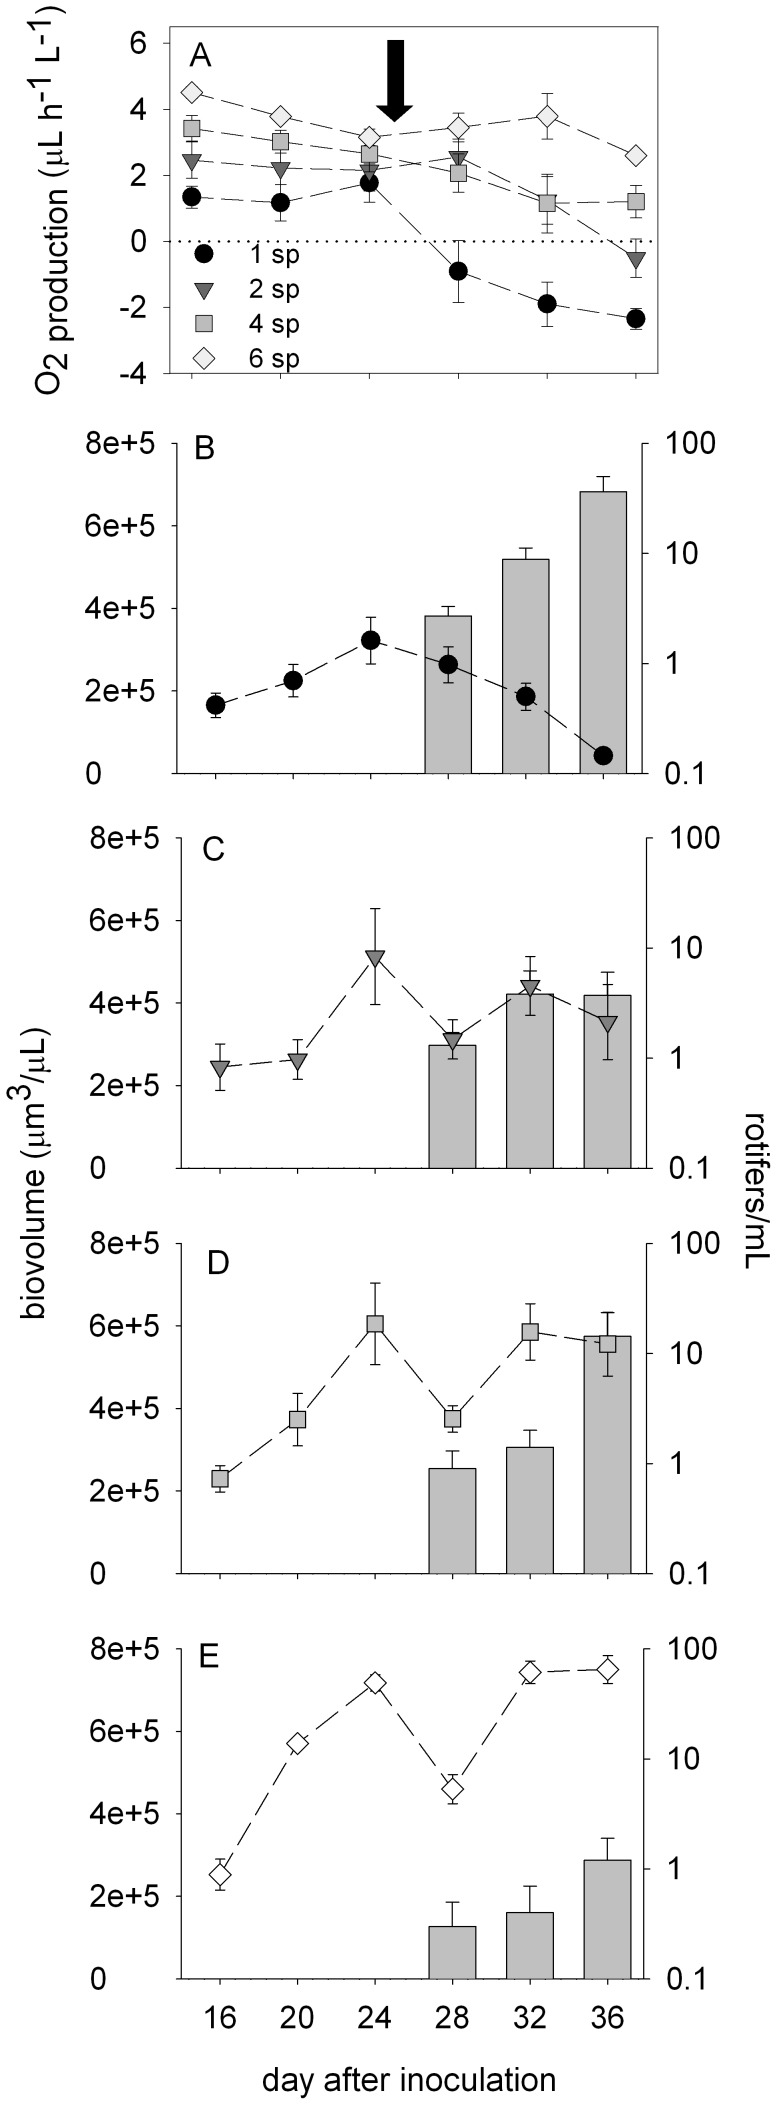
Oxygen production, phytoplankton biovolume and rotifer abundance through time in the different richness treatments.The top figure (A) shows the mean (± SE) net oxygen production of the different richness treatments. The bottom figures show total phytoplankton biovolume (symbols) and rotifer abundance (bars) of the one- (B), two- (C), four- (D) and six-species (e) treatments before rotifer addition (first three points) and after rotifer addition (last three points). Points and bars in b-e represent means ± standard errors (n = nine for polycultures, 18 for monocultures). The arrow indicates the point of rotifer addition at an initial abundance of one rotifer per mL. Rotifer abundance is shown on a log scale.